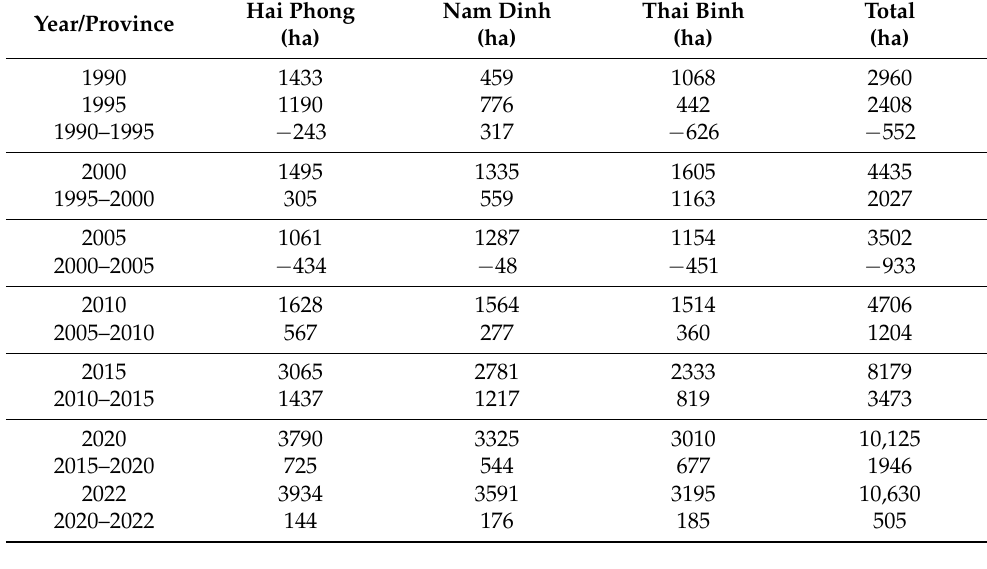
Table 4. The change detection of the mangrove area in the three provinces over 32 years.